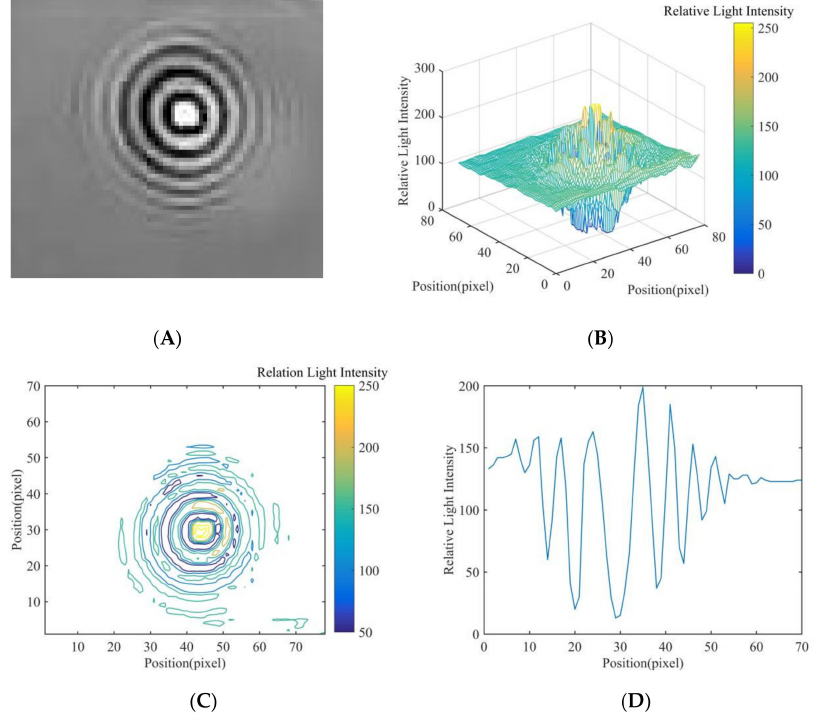
Figure 6. Results of P. xanthii spore fingerprint image processing, ( A ) diffraction image, ( B ) three- dimensional relative light intensity distribution, ( C ) two-dimensional relative light intensity distribu- tion, and ( D ) relative light intensity distribution